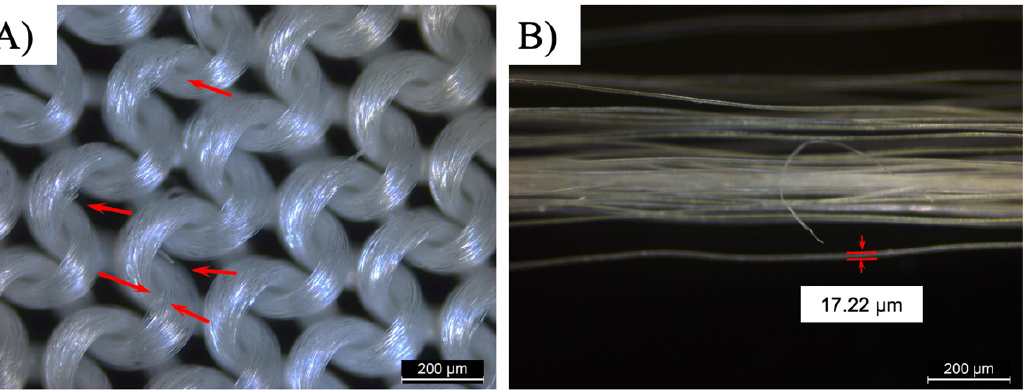
Figure 8. Digital microscopic images of ( A ) PLA/PHB woven fabrics, ( B ) multi-filament yarns used in fabrics after 21 days immersion in seawater under UV + Air condition.